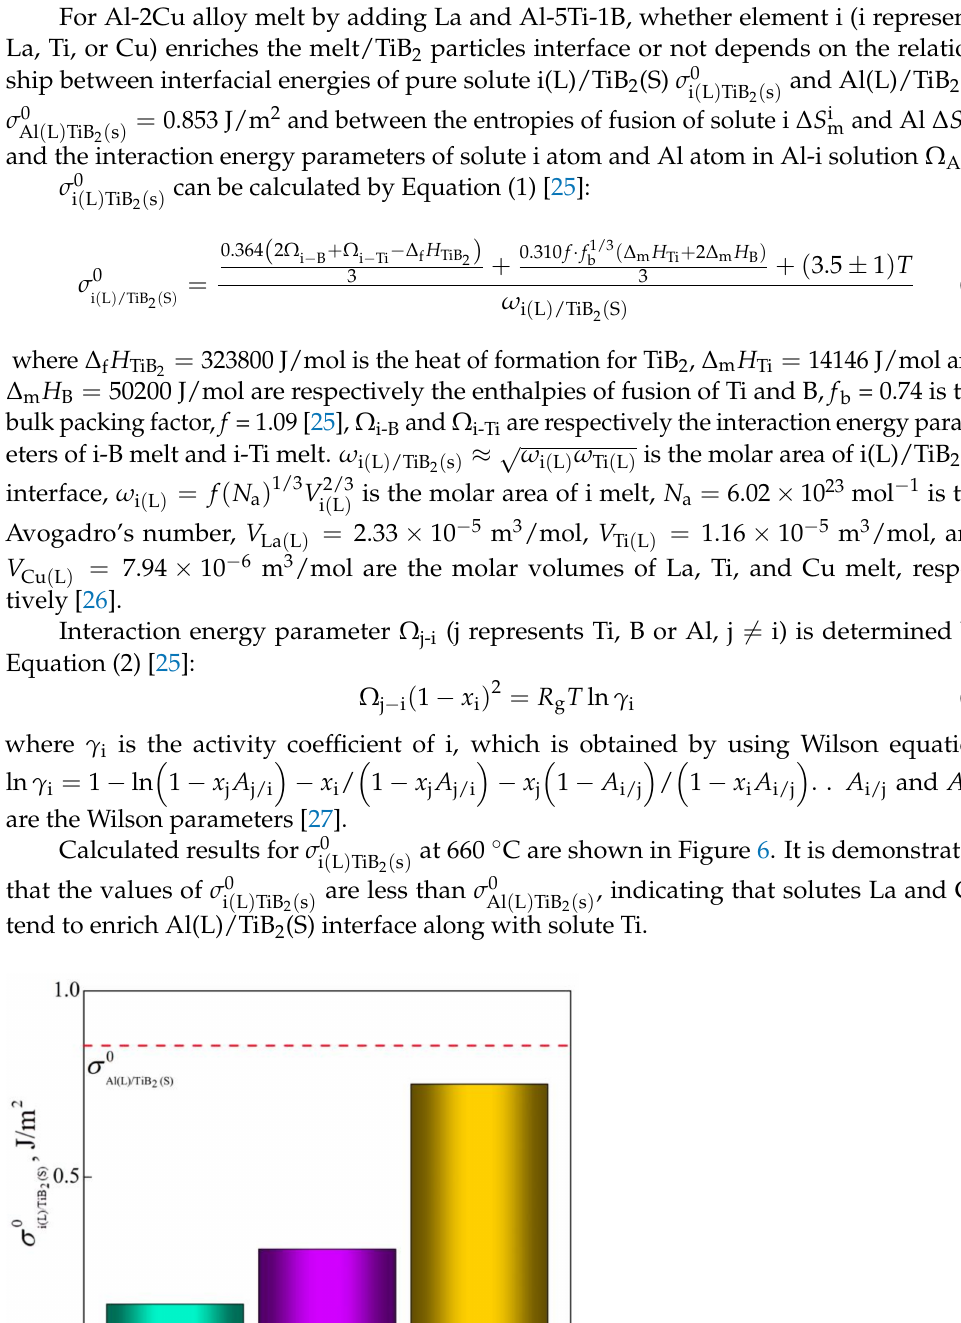
of i(L)/TiB 2 (S) at 660 ◦ i ( L ) /TiB2 ( S )